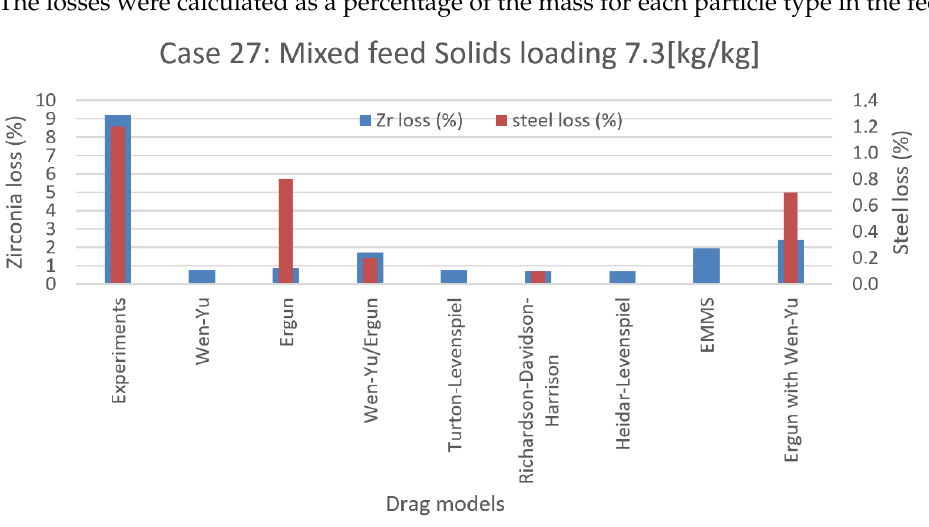
Figure 9. Zirconia and steel loss for Case 27.